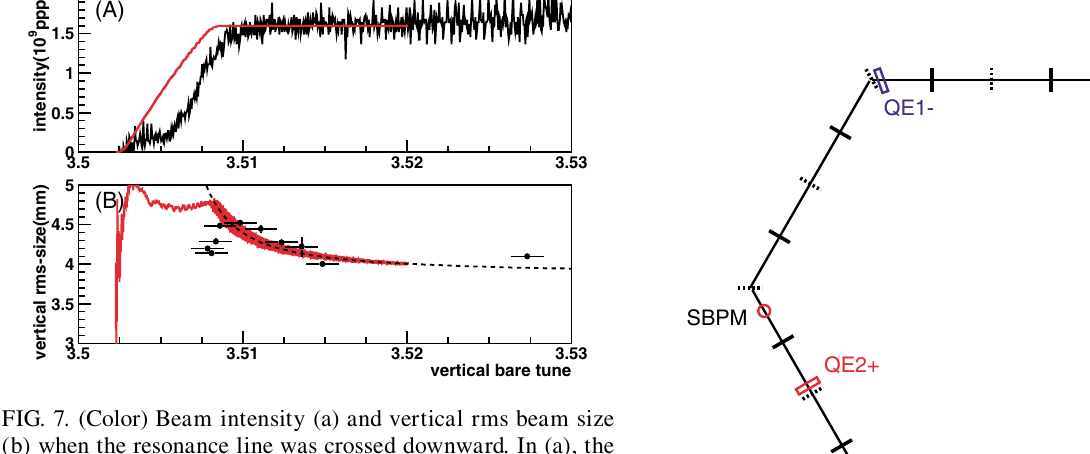
FIG. 6. Vertical beam profiles measured at (cid:2) (a), 3.511 (b), 3.510 (c), and 3.508 (d). Fitting function is the superposition of two